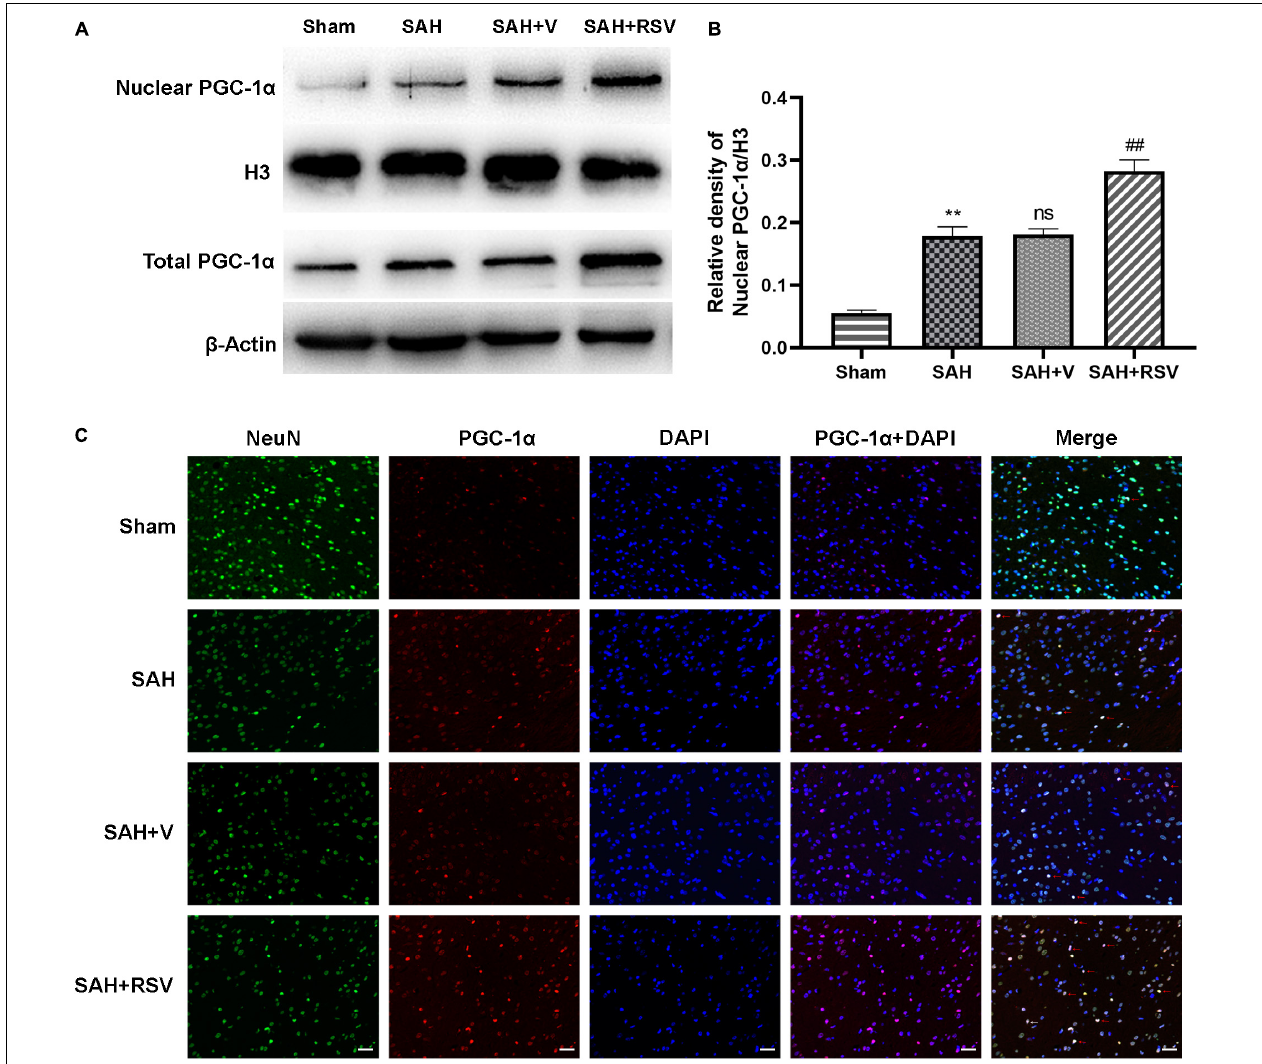
FIGURE 5 | Effect of RSV on mitochondrial biogenesis potentially by the PGC-1 α pathway was evaluated. (A,B) Representative bands of Western blot showed that the level of nuclear PGC-1 α and total PGC-1 α was elevated by RSV treatment. Relative protein levels of nuclear PGC-1 α were standardized to the level of H3. (C) Representative immunofluorescence staining of PGC-1 α demonstrated that RSV promoted PGC-1 α nuclear shuttling. Scale bar = 50 µ m; data were represented as mean ± SEM ( n = 6). ** p < 0.01 vs. sham group; ns p > 0.05 vs. group with SAH; ## p < 0.01 vs. vehicle-treated group.